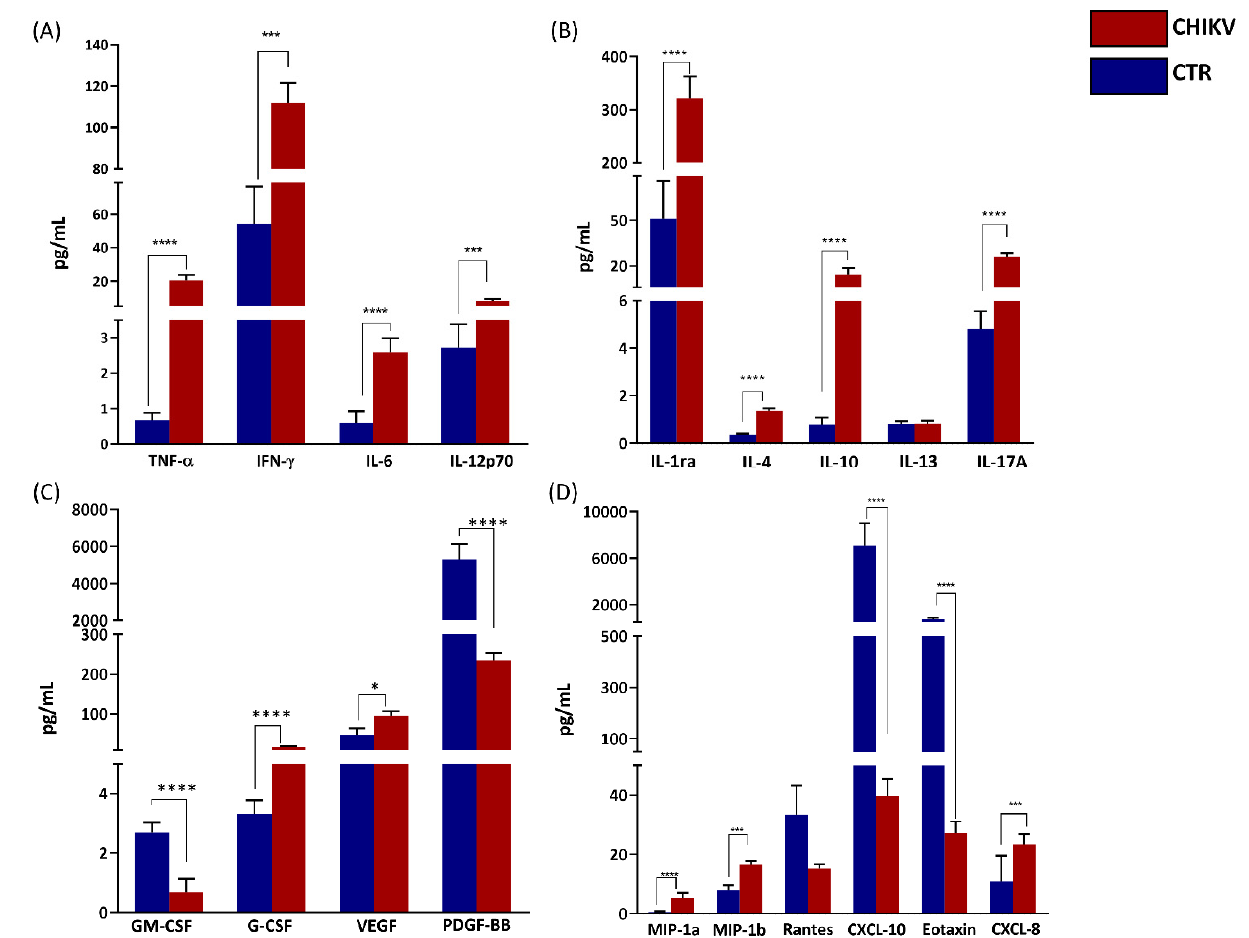
Figure 1. Children exposed in utero to maternal CHIKV infection present an exacerbated inflammatory environment. Quantification of circulating inflammatory mediators were performed by multiplex assay, including proinflammatory cytokines ( A ), anti-inflammatory cytokines ( B ), growth factors ( C ) and chemokines ( D ). Results are expressed as mean and standard deviation of each analyte. For statistical analysis, ANOVA or Kruskal–Wallis was used according to the normality of variables. CHIKV = Chikungunya. CTR = Control. p < 0.05 was considered significant. * p < 0.05; *** p < 0.001; **** p < 0.0001.